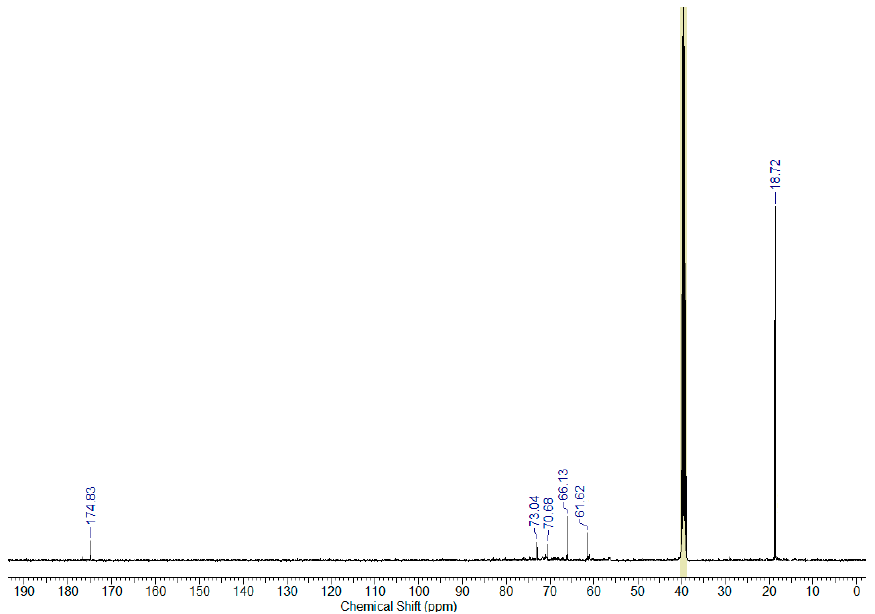
Figure 6. 13 C NMR spectrum of PGL 5/FK—fraction of PGL5/17/T12C16 with –COOH. (100 MHz, DMSO-d 6 ).